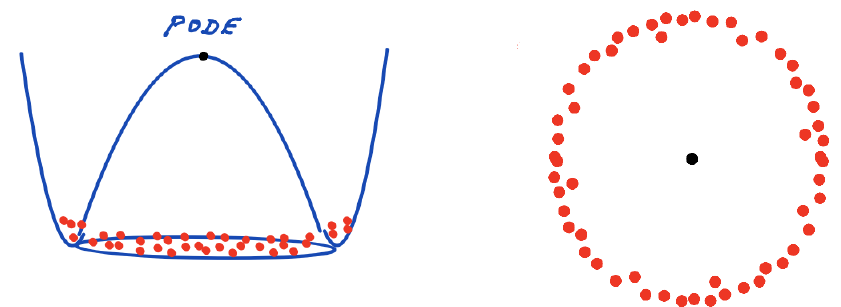
Figure 10. Toy model with stretched horizon. The right panel shows the view from